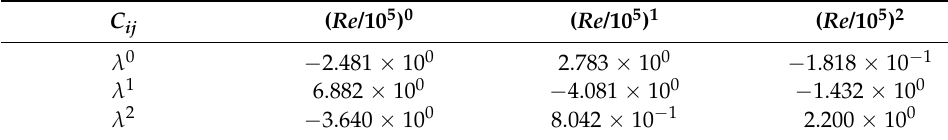
Figure 15. Change in motor efficiency with flight altitude under maximum continuous state.